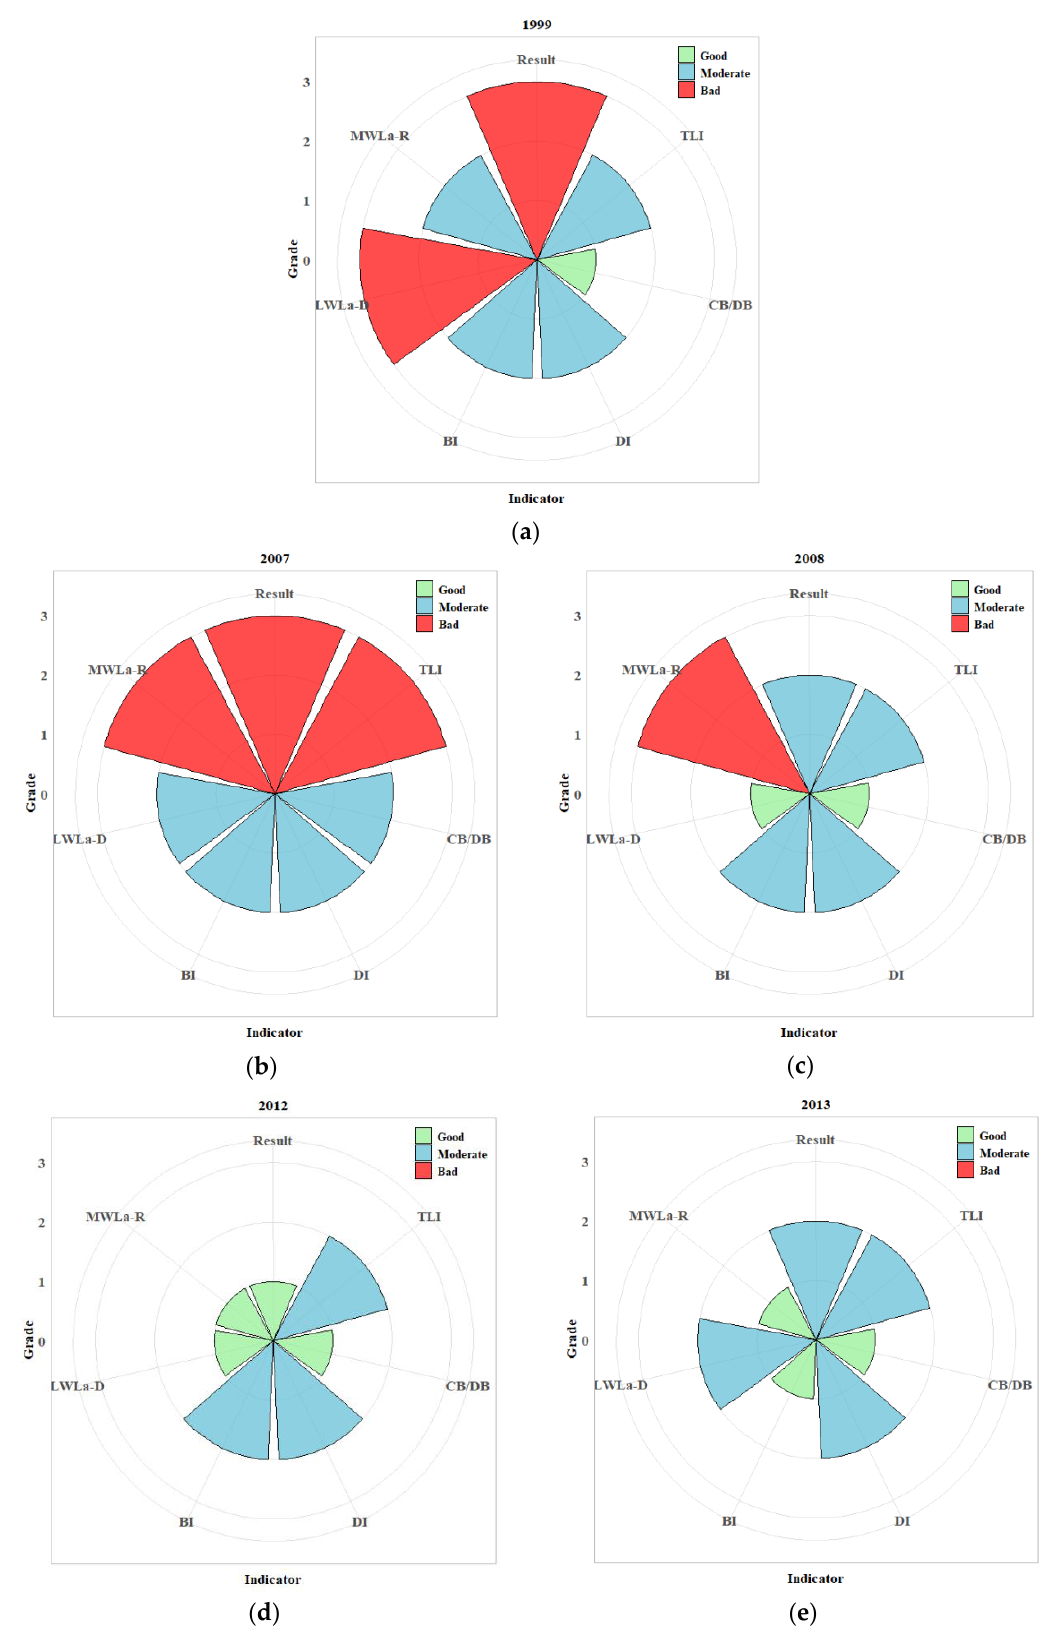
Figure 4. Individual indicator grade and comprehensive grade of the aquatic ecosystem health assessment in Poyang Lake from 1999 to 2013.